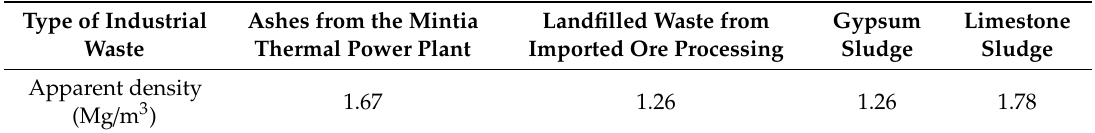
Table 4. Apparent density of the filler materials used.